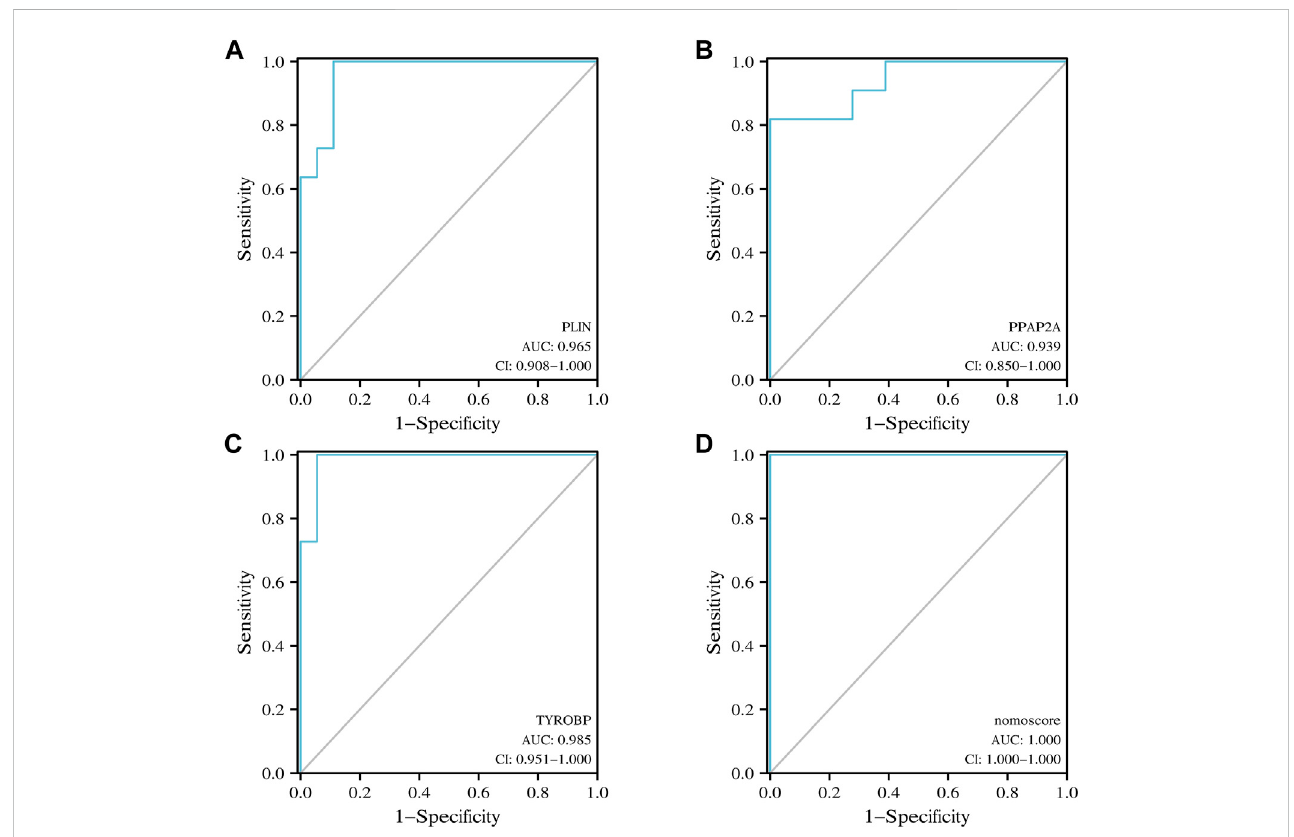
FIGURE 7 (A – D) ROC curve of PLIN, PPAP2A, TYROBP and nomoscore in PVNS and RA samples.